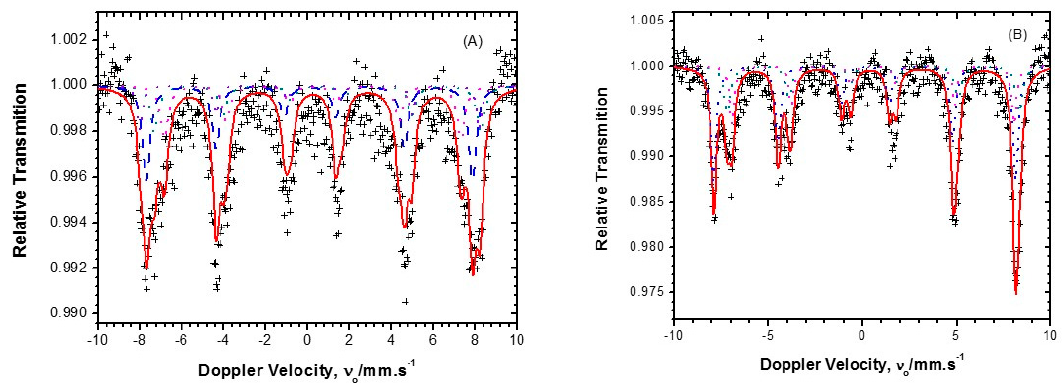
Figure 4. Mössbauer spectra of ( A ) Fe 3 O 4 and ( B ) Fe 3 O 4 @SiO 2 .